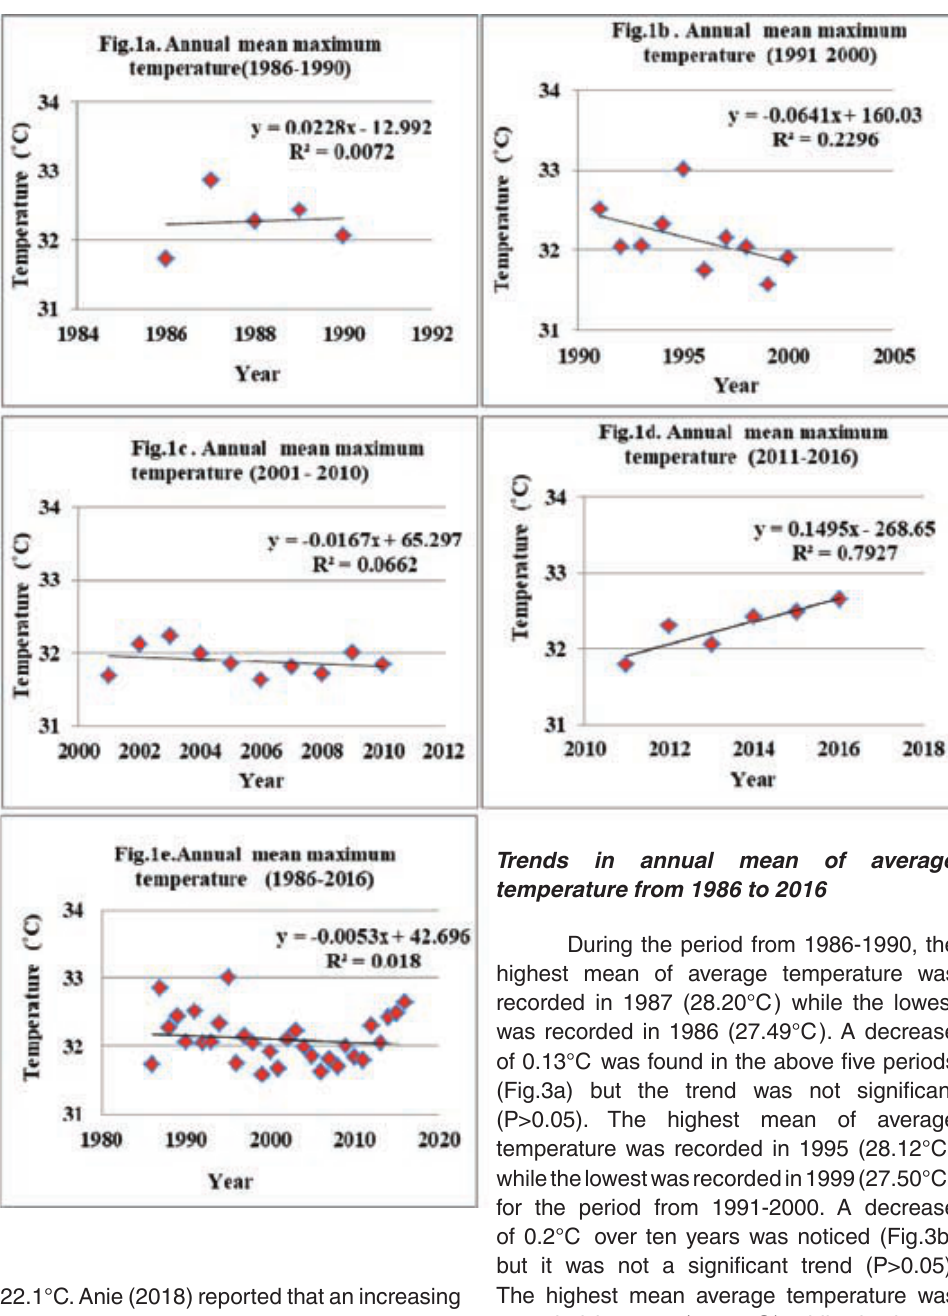
Fig1. Trends in annual mean maximum temperature from 1986 to